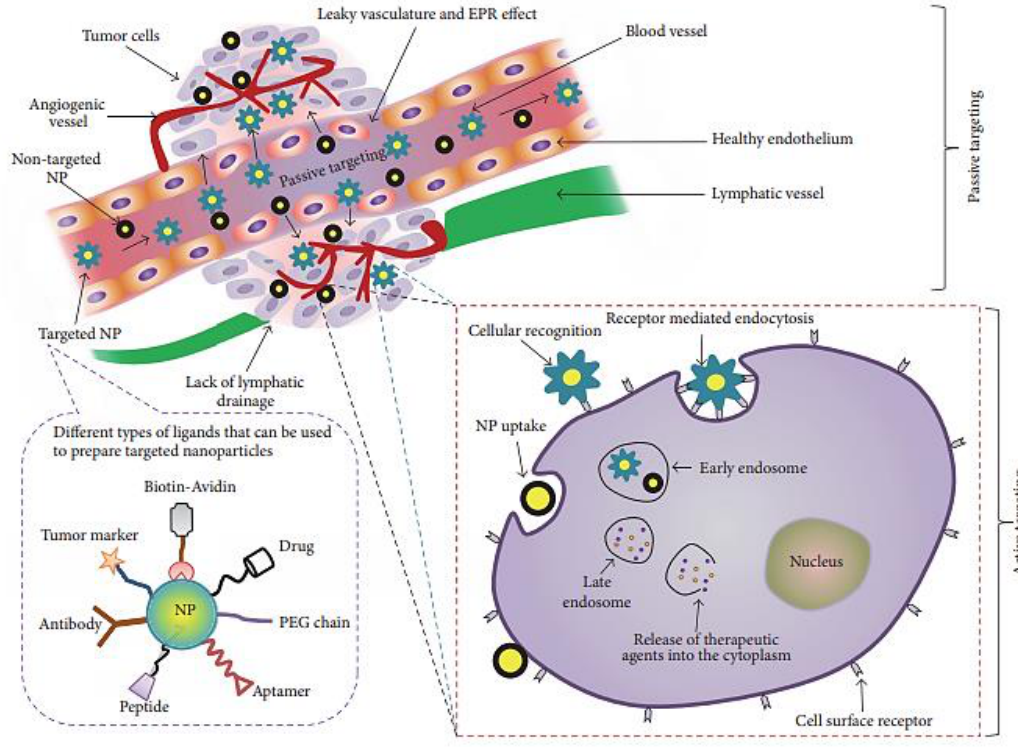
Figure 1. Schematic representation of passive and active targeting approaches. The figure is reproduced from Reference [27] with the permission from Hindawi.